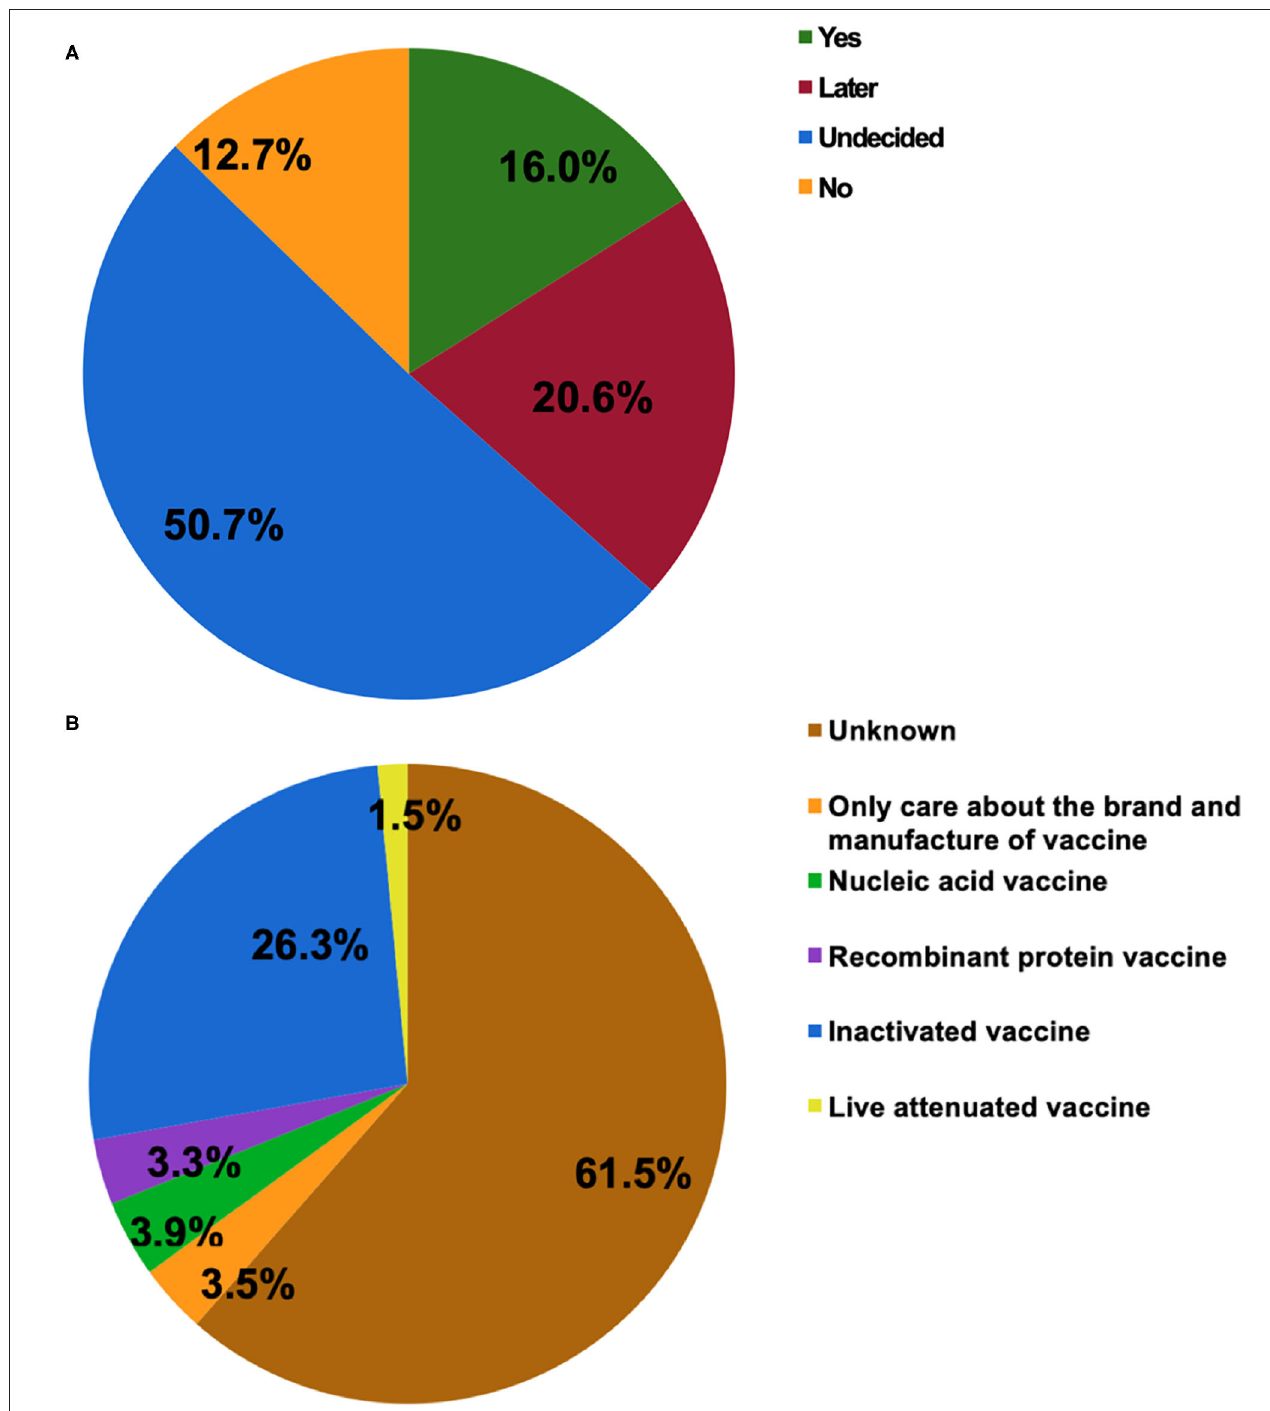
FIGURE 1 | The attitudes of patients with inflammatory bowel disease (IBD) toward COVID-19 vaccination (A) . The type of COVID-19 vaccines that participants would prefer to receive (B) .